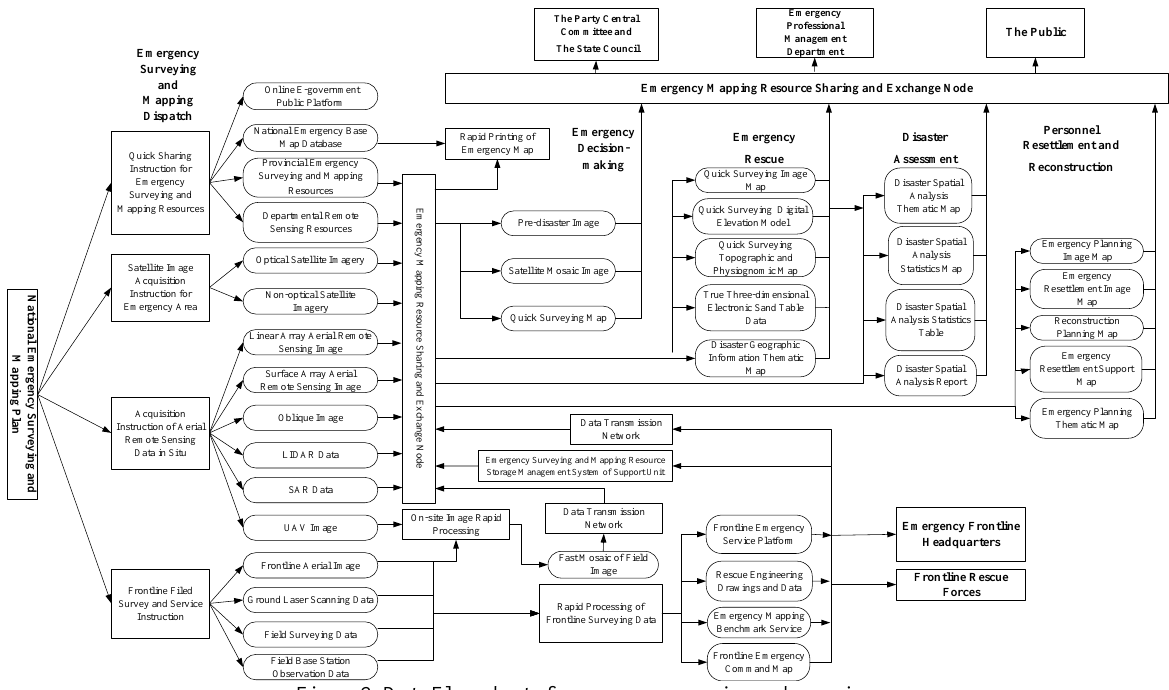
Figure 2. Data Flow chart of emergency surveying and